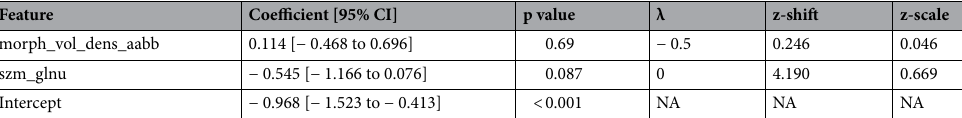
Table 3. Information on features and intercept in the final logistic regression model for the atypical subtype: coefficients with 95% confidence intervals (CI) along with model p values, Yeo–Johnson (λ) and z-transform (z-shift and z-scale) parameters.